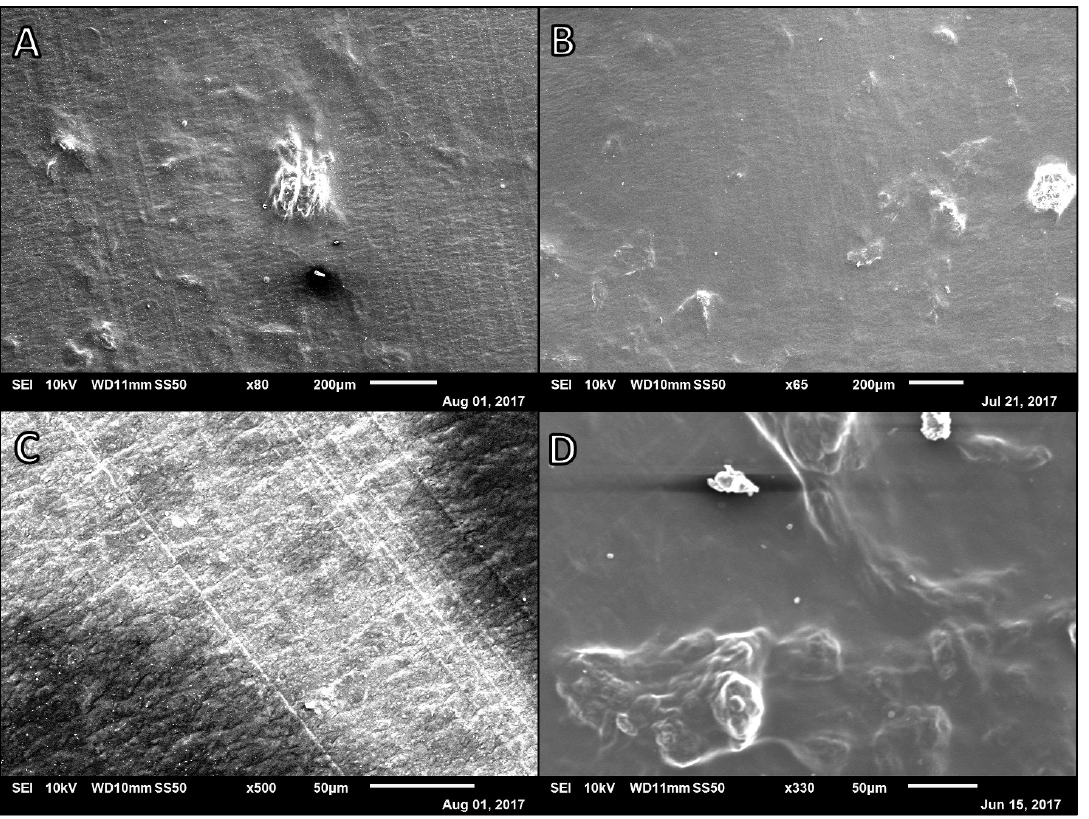
Figure 4. SEM micrographs of 1:1 2.5% Alg: agarose (Ag) samples at various concentrations of agarose spun with a target distance of 100 mm. ( A ) 0.5% Ag at 5.8 μL/min, 25 kV, and 1 mL disp.; ( B ) 0.5% Ag at 7.5 μL/min, 30 kV, and 0.2 mL disp.; ( C ) 0.75% Ag at 5.8 μL/min, 22 kV, and 1 mL disp.; and ( D ) 1% Ag at 7.5 μL/min, 19 kV, and 1 mL disp.